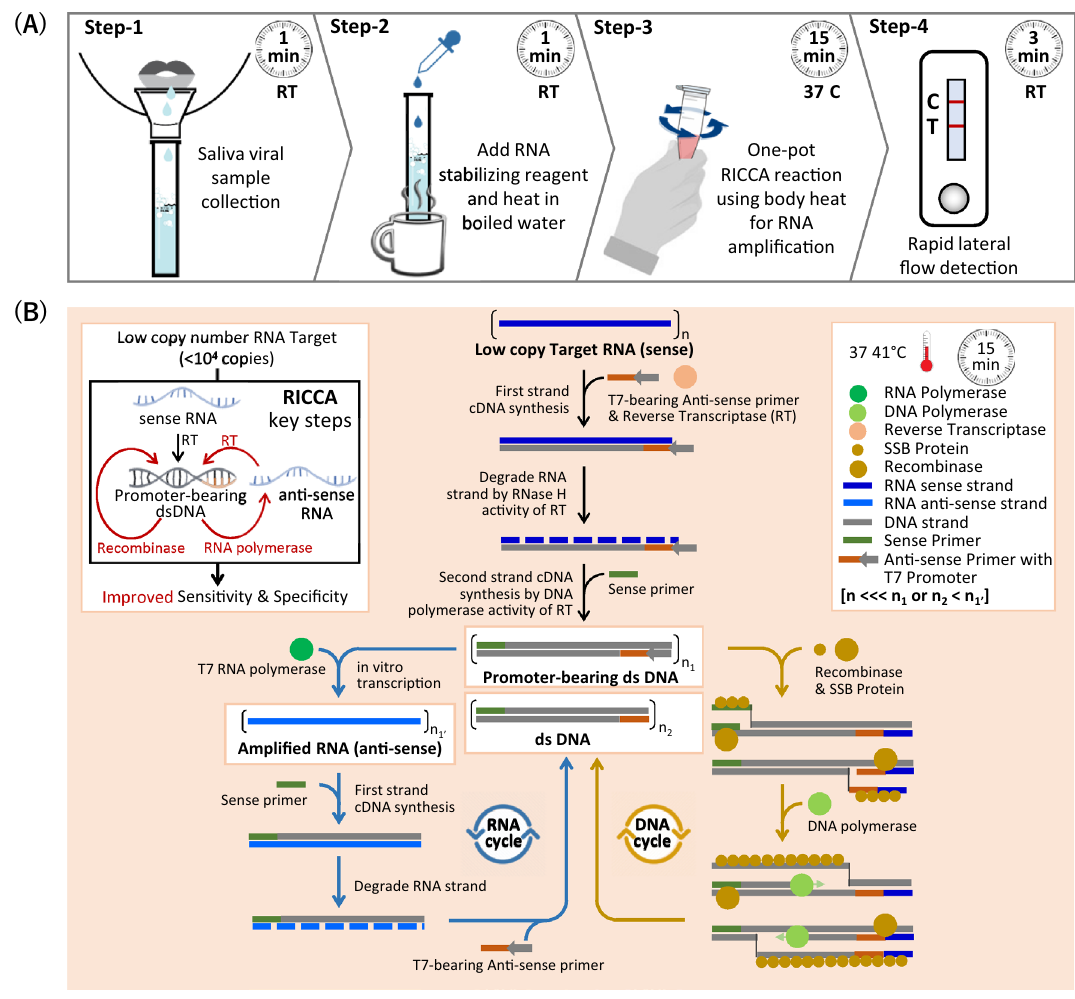
Figure 1. RICCA (RNA Isothermal Co-Assisted Coupled Amplification) test concept and mechanism. ( A ) A working flowchart for the rapid, reliable and field-deployable molecular testing of RNA virus with a sample-to- answer period of less than 20 min using a lateral flow device-powered RICCA test. The four simple operation steps are as follows: a 1-min protocol for easy and painless saliva sampling is used for the collection of biological virus samples (step-1) and for the release of viral RNA (step-2). Next, the lysed solution is directly used for one- pot coupled isothermal RNA and DNA amplification reactions at a temperature near 37 °C for 15–30 min (step- 3). Qualitative results are visualized by the naked eye using a DNA lateral flow immunochromatographic assay in 3 min (step 4). ( B ) Schematics of the mechanism and the key steps involved in the RICCA assay to overcome the inevitable challenging features of conventional isothermal amplification